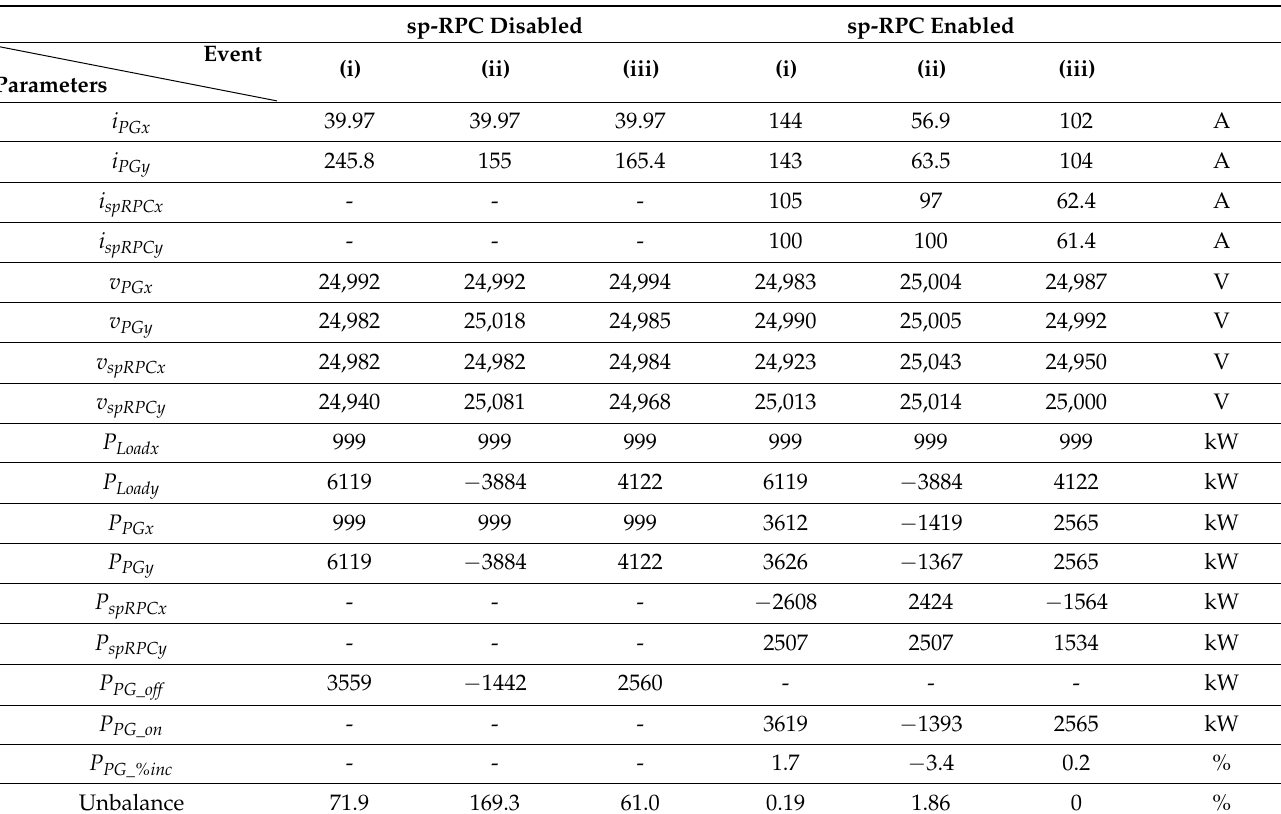
Table 3. Currents and voltages rms values, and active power and unbalance value for different locomotive consumption before and after the sp-RPC being